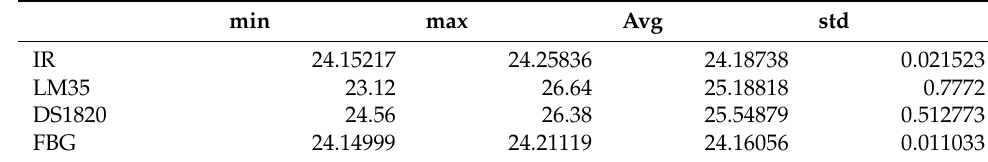
Table 2. statistics of the measurements at PCC point.